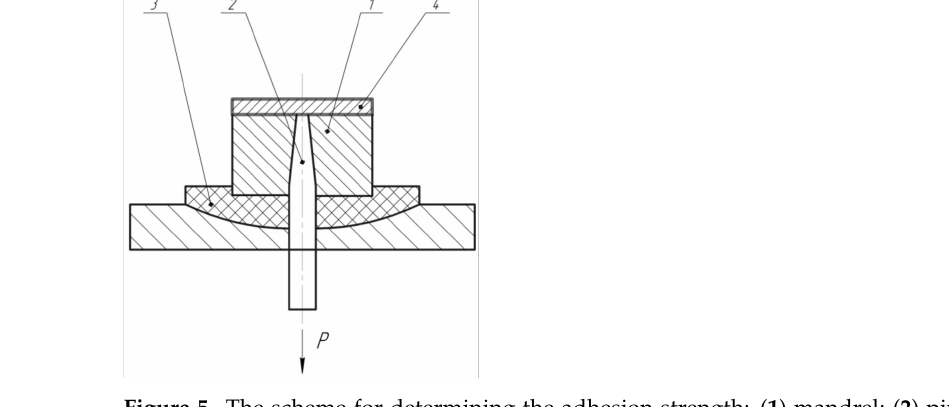
Figure 5. The scheme for determining the adhesion strength: ( 1 ) mandrel; ( 2 ) pin; ( 3 ) emphasis; ( 4 ) and composite tape.